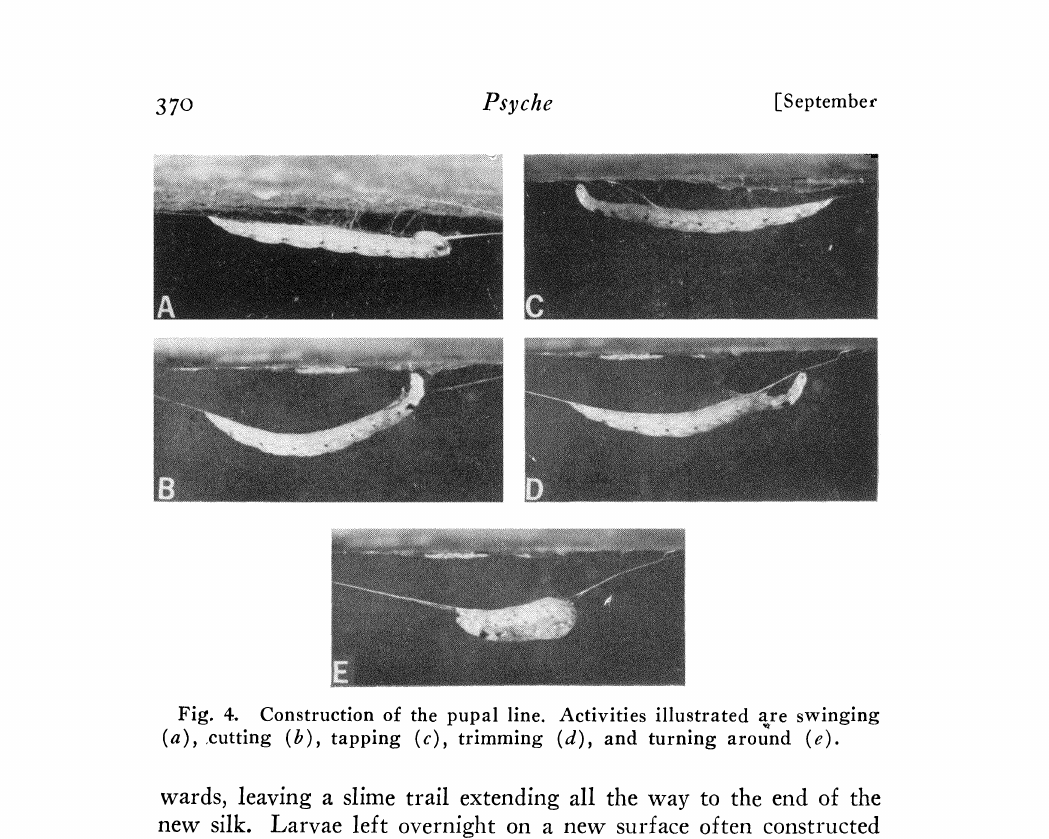
Fig. 4 Construction of the pupal line. Activities illustrated are swinging (a), .cutting (b), tapping (c), trimming (d), and turning around